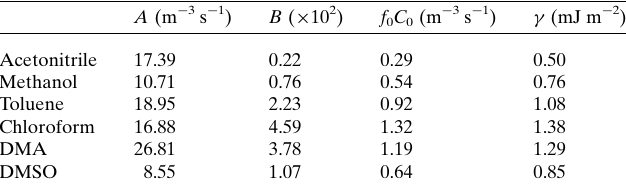
Table 1 Calculated kinetic and thermodynamic parameters for PHEN nucleation in different solvents.